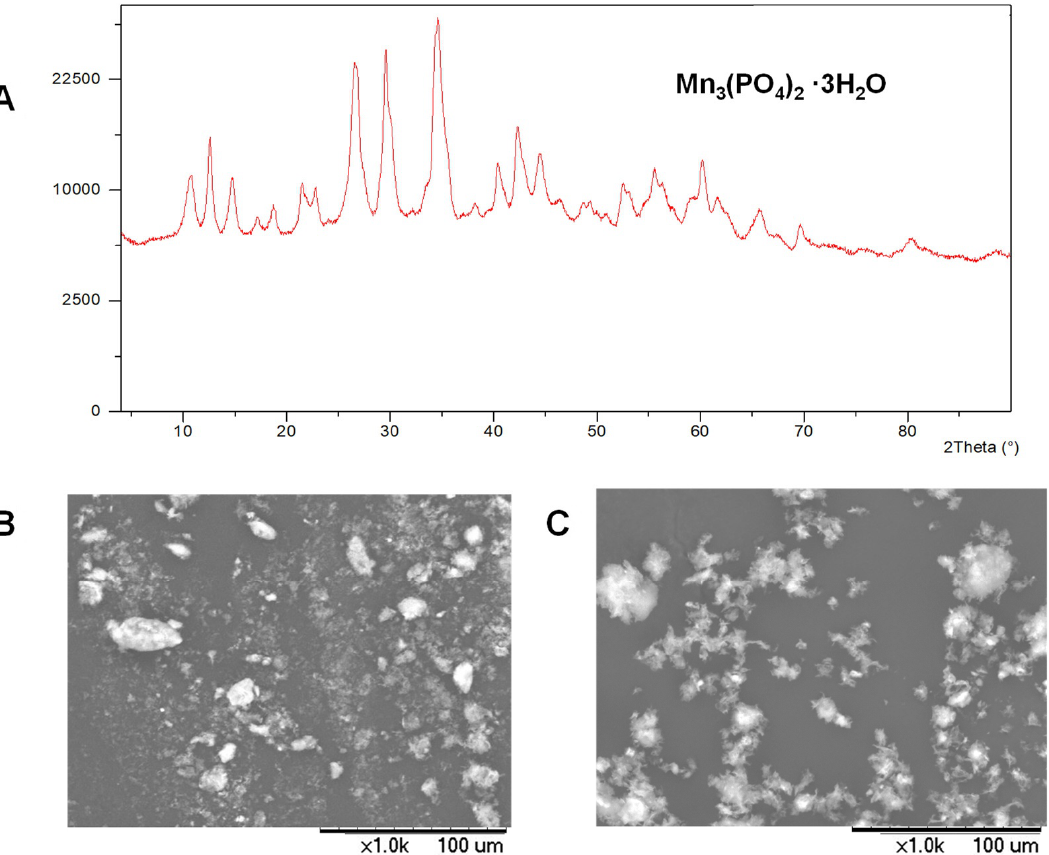
Figure 3. Characterization of MnNPs@CALB hybrids: ( A ) XRD spectrum; ( B ) SEM images of MnNPs@CALB-P ; ( C ) SEM images of MnNPs@CALB-P-NR .